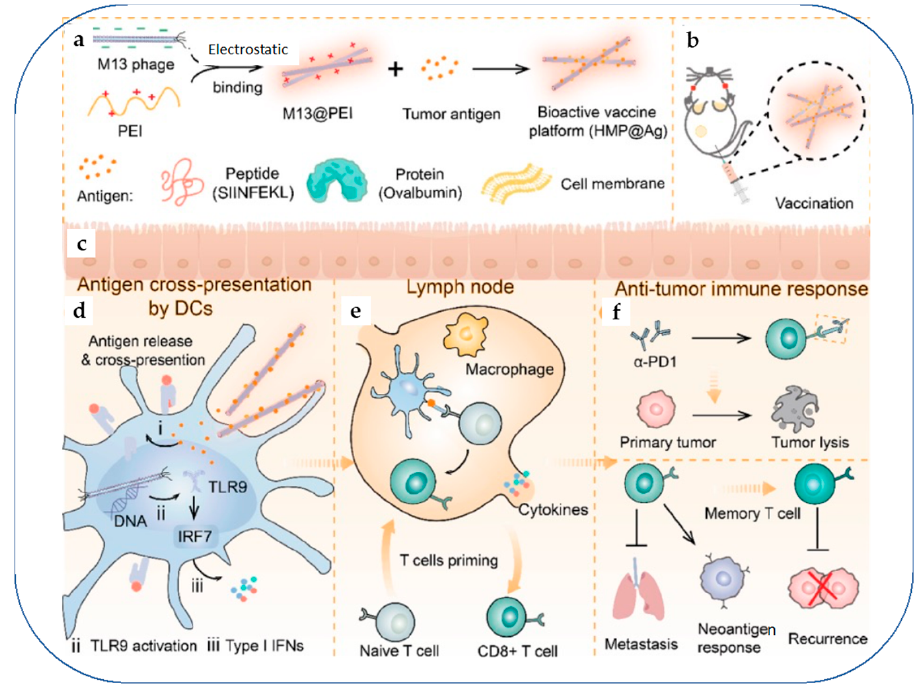
Figure 10. Representation of M13 phage-based vaccine platform design. ( a ) Development of the hy- brid M13 phage vaccine ( b , c ) loaded with tumour antigens. Schematic diagram representing the